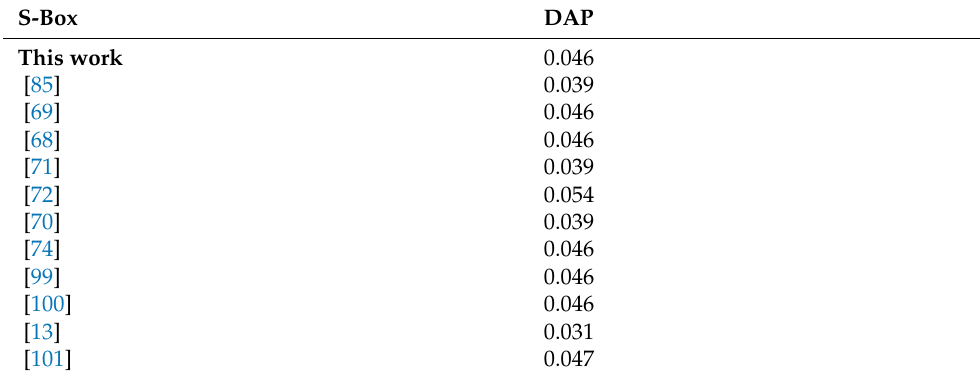
Table 8. Comparison of max differential probability of some